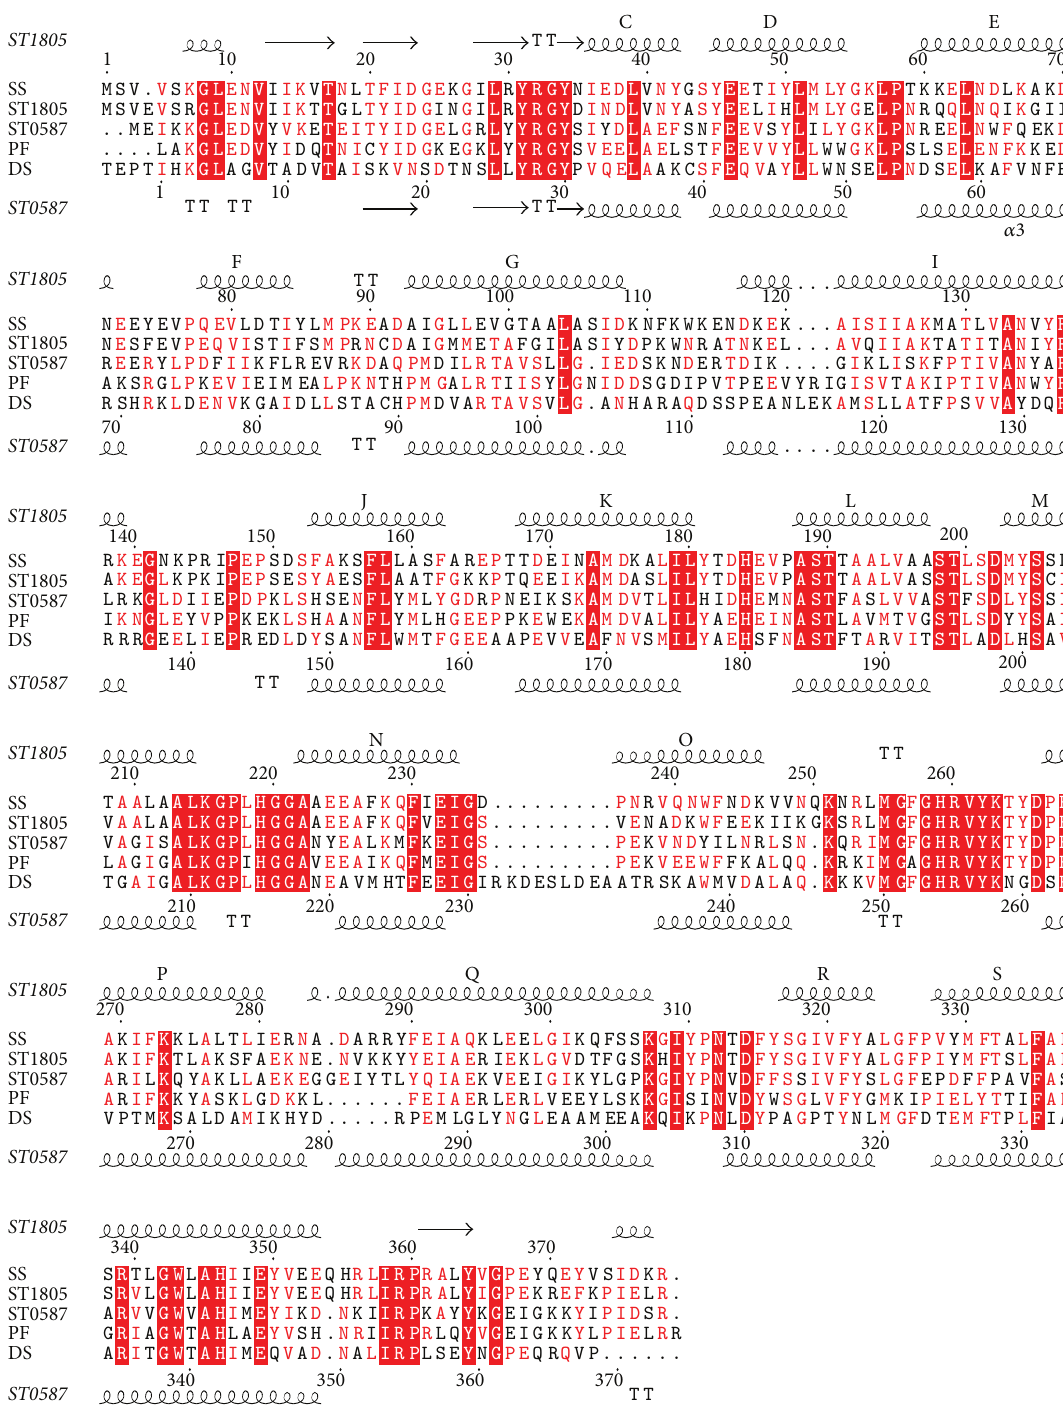
Figure 1: Multiple alignment of sequences for microbial CSs. SS; CS from S. solfataricus , ST1805; ST1805-CS, ST0587; ST0587-CS, PF; CS from Pyrococcus furious , DS; CS from Arthrobacter Ds2-3R . The secondary structure elements were indicated and labeled as C to G and I to S for 𝛼 -helices, whose nomenclature was proposed by Remington et al. [8]. Identical residues were shaded in red; similar residues were colored